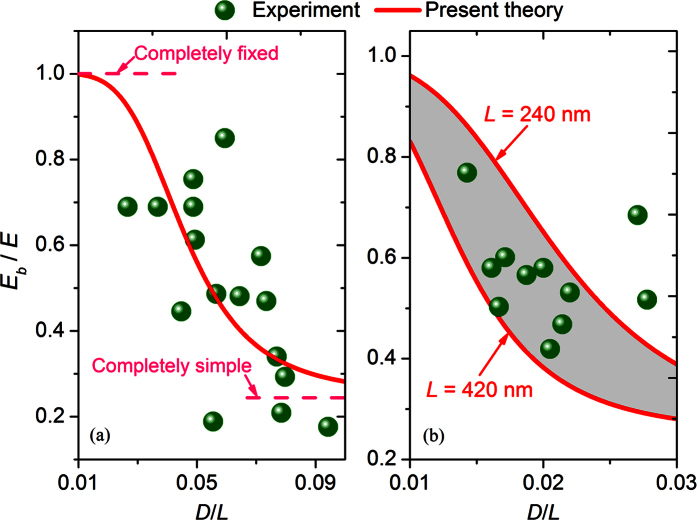
The relevance of the present theory of imperfect BCs to the size-dependent bending modulus of (a) BNNTs15 and (b) CNTs10 measured in experiments.